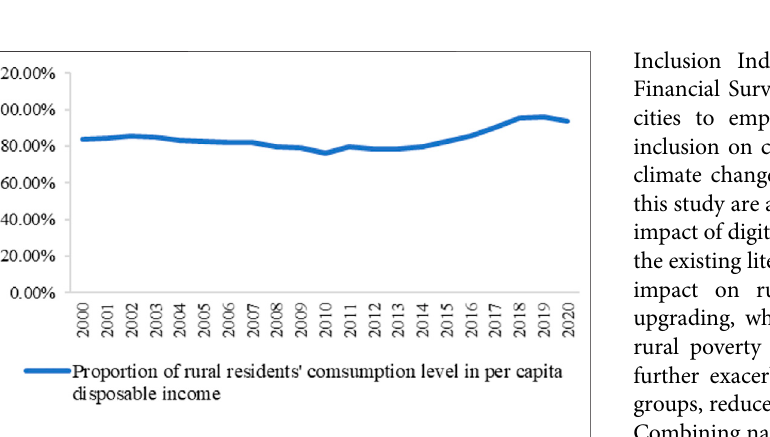
FIGURE 3 | Proportion of rural residents ’ consumption in per capita disposable income from 2000 to 2020 (Data source: National Bureau of Statistics of